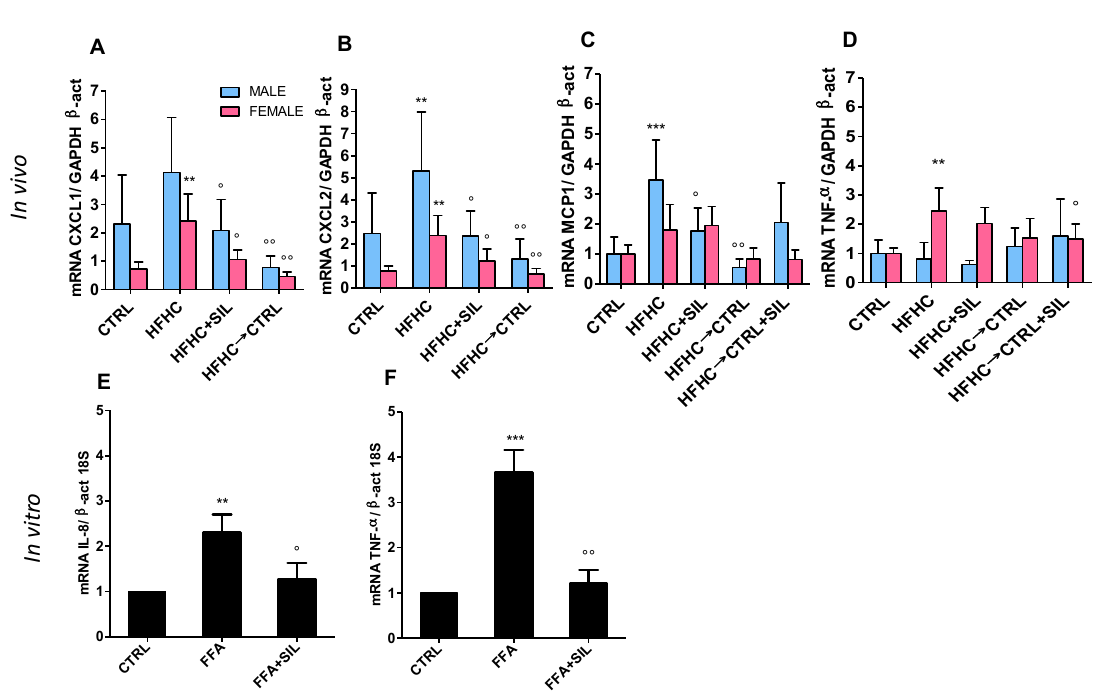
Figure 4. Molecular analysis of hepatic pro-inflammatory genes. The expression of pro-inflammatory mediators was assessed both in vivo ( A – D ) and in vitro ( E – F ). ** p < 0.01 vs. CTRL; *** p < 0.001 vs. CTRL and ◦ p < 0.05 vs. HFHC; ◦◦ p < 0.01 vs. HFHC/FFA.